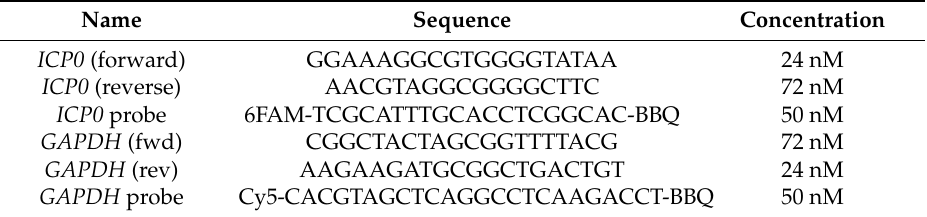
Table 2. Primer and probe sequences used for qPCR of viral and cellular